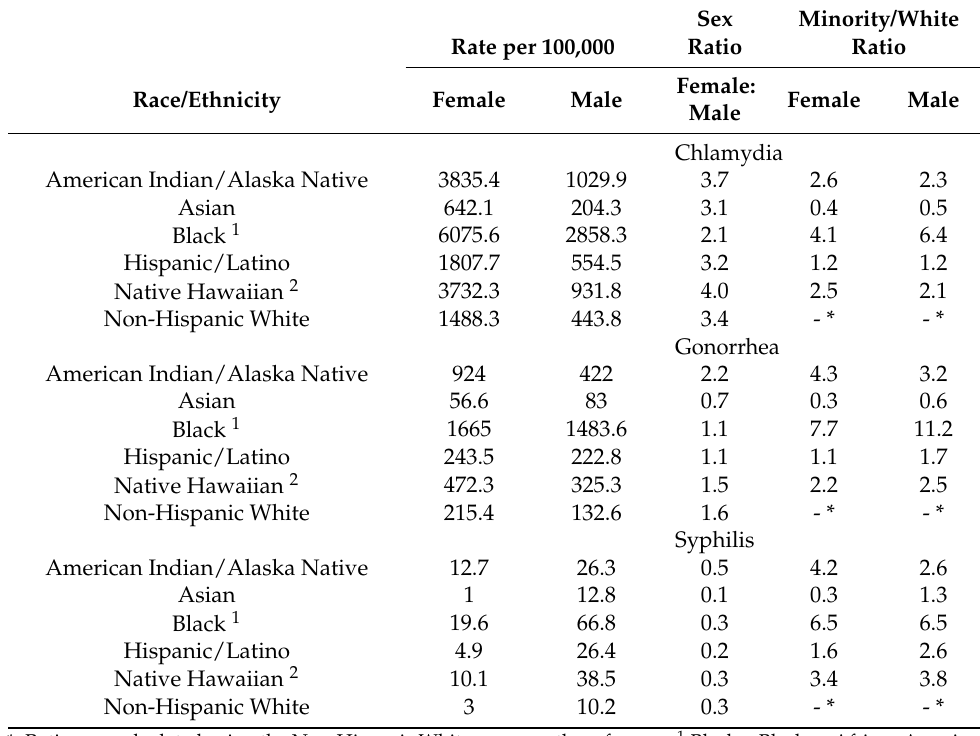
Non-Hispanic White 3